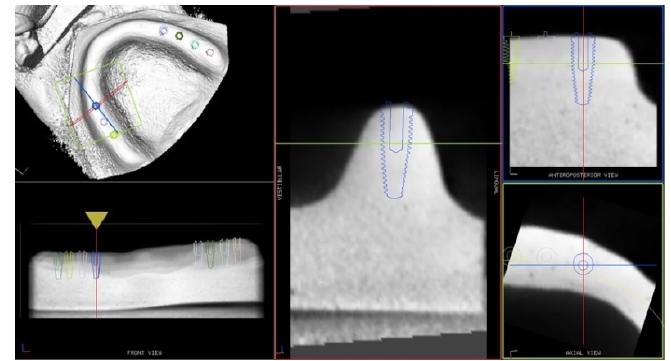
Figure 1. Plan of the implants position on the model CBCT images.